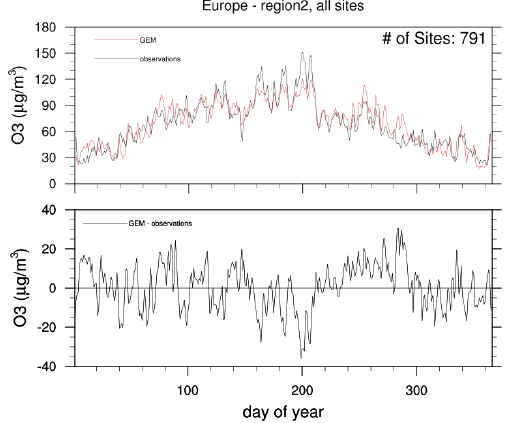
Figure 7. Time series of observed and modelled maximum 8h running averaged ozone concentration averaged for all stations in northern Europe and MBE.